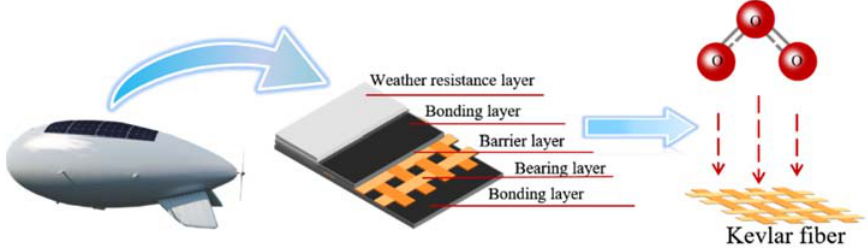
Figure 1. Schematic diagram of Kevlar fiber of airship envelope eroded by ozone in near-space.